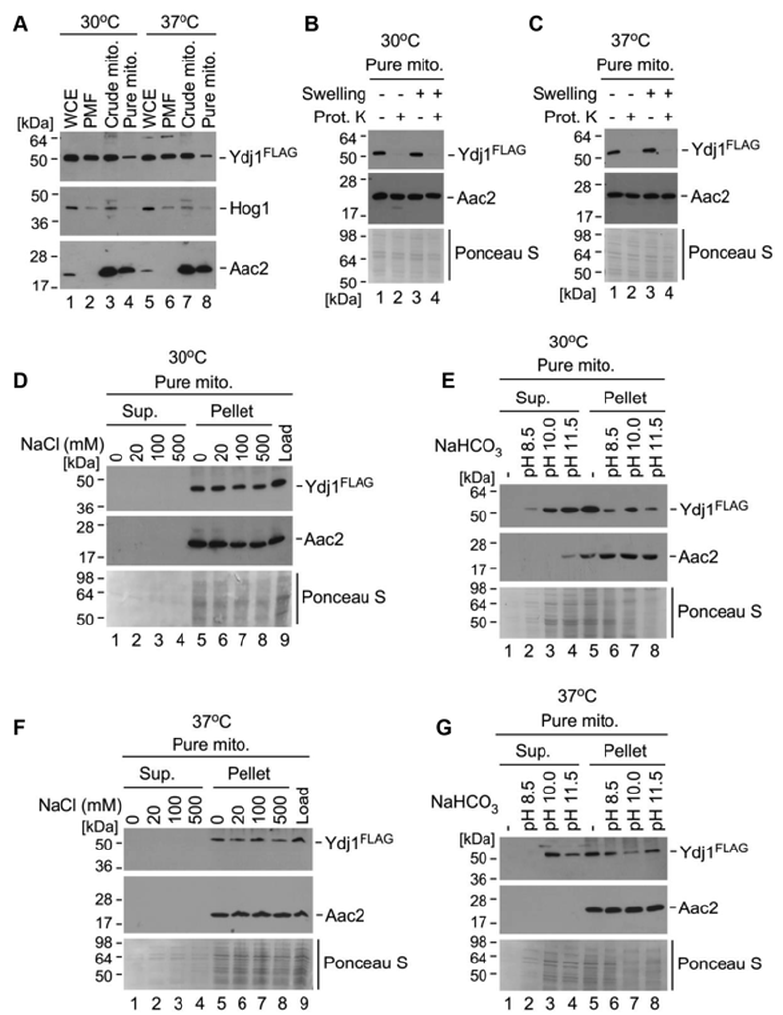
FIGURE 8: Mitochondrial fraction of Ydj1 is tightly associated with the outer membrane. (A) A fraction of Ydj1 is localised to mitochon- dria. WCE, PMFs and mitochondria isolated from 2×FLAG- YDJ1/ydj1 Δ yeast cultures grown and immunoblotting with antibodies